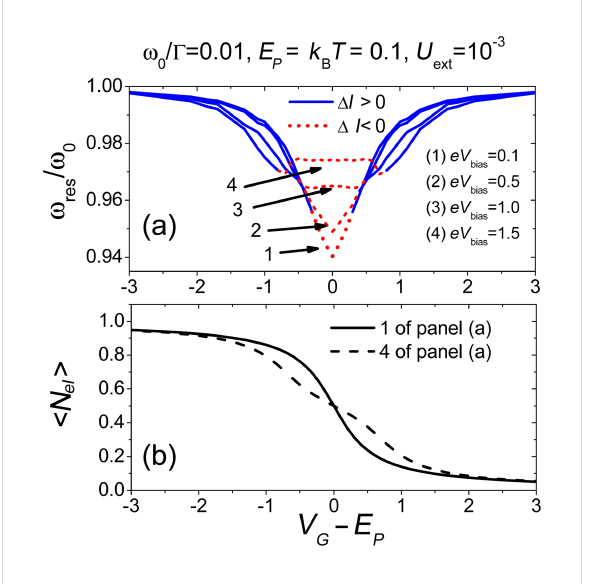
Figure 11: Interplay between the resonator frequency and the charge density. Panel (a): Resonator frequency at resonance against effective gate voltage (shifted of E P ) for different bias voltages. Solid (blue) and short-dashed (red) portions of each curve indicate resonance frequen- cy values with positive and negative current change Δ I , respectively. Panel (b): Electronic occupation at resonance frequency against effective gate voltage (shifted of E P ). Adapted from